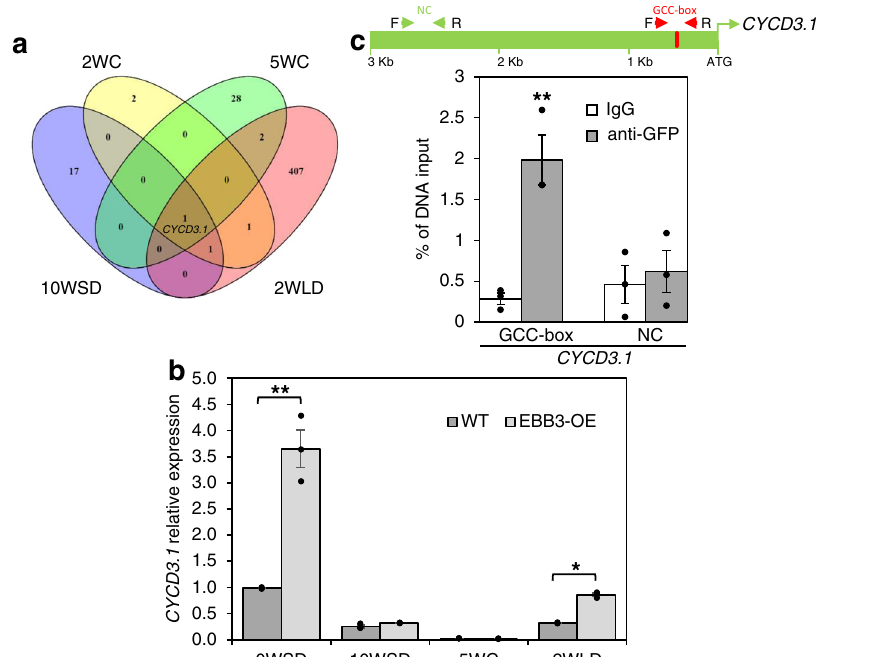
Fig. 6 EBB3 binds directly to the CYCD3.1 promoter in vivo in chromatin immunoprecipitation assays to regulate its expression. a Number of common and unique downregulated genes in EBB3 RNAi under-expressing plants in different dormancy stages. The Cyclin D3.1 ( CYCD3.1 ) is the only downregulated gene in all dormancy stages. See Supplementary Data 4 – 7 for more details. b Relative expression of CYCD3.1 in EBB3-OE and WT-717 plants; 0W: time point before inductive treatments, 10WSD: 10 weeks under SD photoperiod, 5WC: 5 weeks under cold, 2WLD: 2 weeks under LD photoperiod and warm temperature, expression values are normalized to the ACT7 gene. Expression values are the average of three biological replicates ±SEM. c Enrichment of a DNA fragment in the CYCD3.1 promoter containing a GCC-box and quanti fi ed by ChIP-qPCR. The green box is a schematic representation of the CYCD3.1 promoter showing the position of the GCC-box (red). Red arrows delineate the position of DNA fragments containing the GCC-box and green arrows demarcate the position of DNA fragments with no GCC-box used as a negative control (NC) in ChIP-qPCR analysis. Chromatin from EBB3-GFP DNA transfected poplar protoplasts was isolated using anti-GFP antibody and IgG used as a control antibody. ChIP-puri fi ed DNA was used to perform ChIP- qPCR, expression values are represented as percentage input (% input) DNA. Values are the average of three biological replicates ±SEM. Asterisks (*) and (**) indicate signi fi cant differences compared to their respective control at P < 0.05 and P < 0.004 respectively and determined using two-tailed paired multiple t -tests. Source data underlying Fig. 6a and c are provided as a Source Data fi